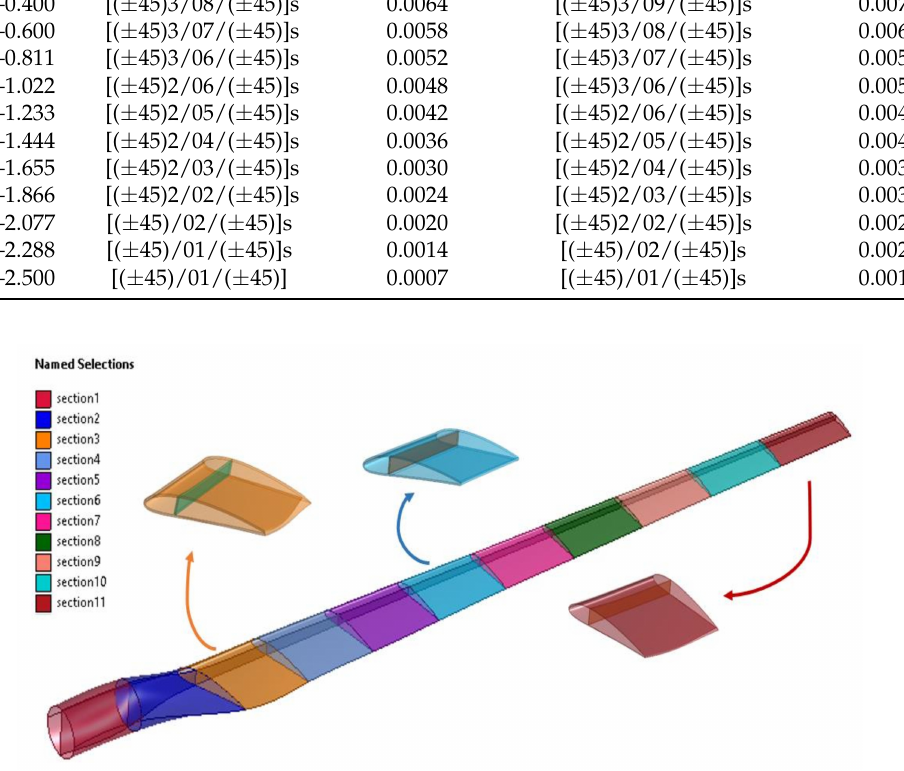
Figure 5. 3D model of the composite blade with 10